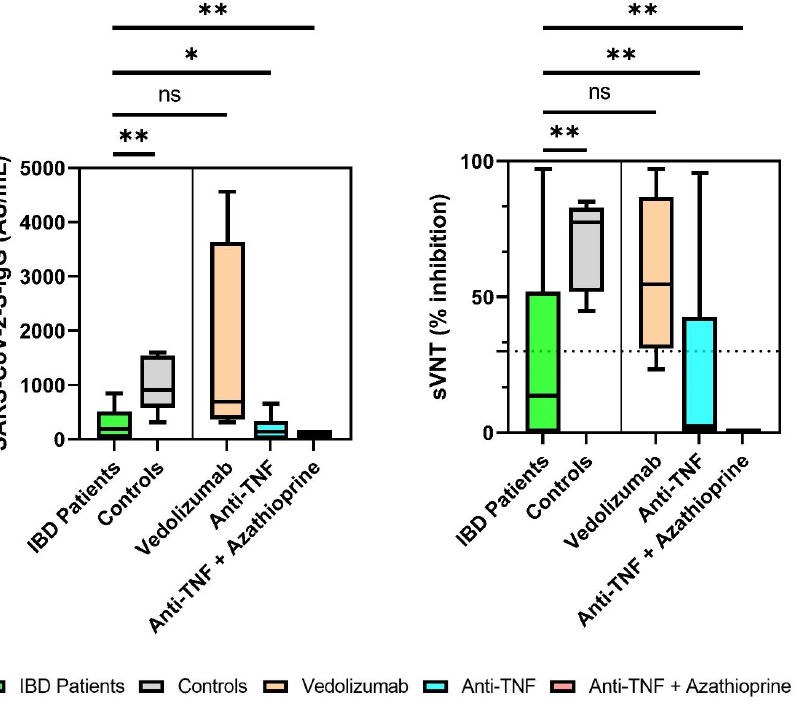
Figure 2. Comparison of SARS-CoV-2-S IgG levels between IBD patients on immunosuppressive therapy and healthy controls 6 months after the second vaccination ( a ) and of sVNT inhibition levels in IBD patient subgroups and healthy controls 6 months after the second vaccination, with the rep- resentation of the cut off value (30% inhibition) noted as a dashed line ( b ). * p < 0.05, ** p < 0.01. ns, not significant. Continuous variables were compared with the t -test if normally distributed, and with the Mann – Whitney U test (Wilcoxon) if not normally distributed. For comparison of more than two groups, the Kruskal – Wallis test was performed. To compare subgroups, the Bonferroni correc- tion post hoc test was performed when the variance was equal (Levene’s test), and the Ga mes – Howell test was performed when variance was different. Six months after the second COVID-19 vaccination, significantly lower seroconver- sion rates according to sVNT (inhibition > 30%) were observed in the immunocompro- mised IBD patients compared to the healthy controls (45% vs. 100%, p = 0.005). In contrast, SARS-CoV-2-S IgG levels (seropositivity > 49 AU/mL) 6 months after the second vaccina- tion did not show significantly higher conversion rates in healthy controls (100%) com- pared to IBD patients (75%, p = 0.153). Depending on the existing immunosuppressive therapy (vedolizumab, anti-TNF, anti-TNF + azathioprine), there were no significant dif- ferences with respect to seroconversion rates (sVNT, S-IgG) (Figure 3a,b).